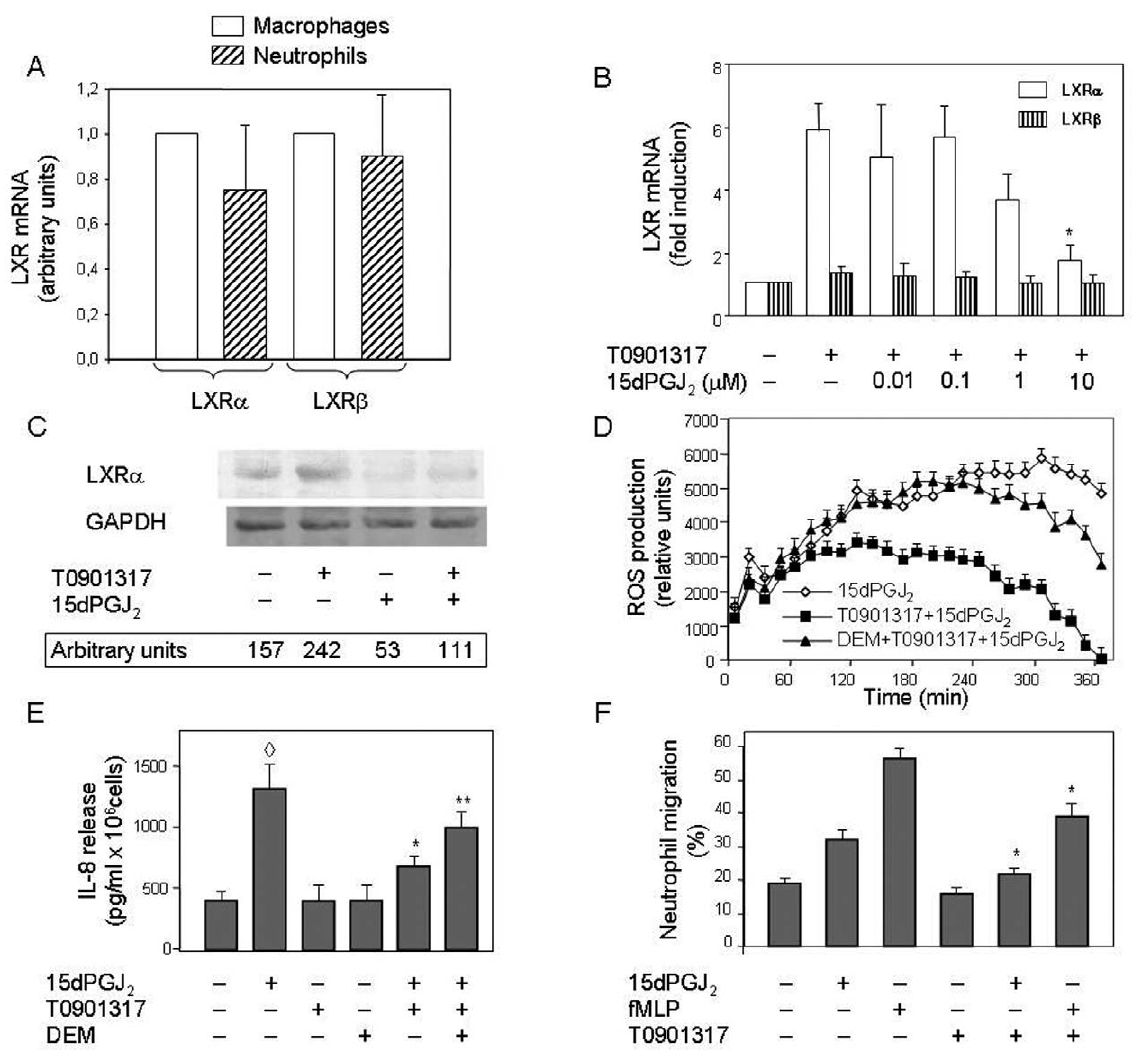
Figure 1. 15dPGJ 2 prevents ligand-induced LXR a mRNA expression in a dose-dependent manner. Neutrophils or macrophages were left untreated (A), or else neutrophils were preincubated at 37 u C for 1 h with or without 15dPGJ 2 at the indicated doses (B) or at a 10 m M concentration (C), and then they were treated or not with T0901317 for 18 h (B and C). Then LXR a and LXR b mRNA levels were measured by real time RT-PCR (A and B), or LXR a protein levels were analyzed by Western blotting (C). Statistical data from real time RT-PCR experiments were normalized to LXR a or LXR b levels found in human macrophages (A) and corrected for differences in b -actin mRNA levels (as endogenous gene) and expressed as fold induction (A and B). GAPDH bands in Western blots are shown for the sake of protein loading controls (C). In a different set of experiments, neutrophils were pretreated or not with 10 m M DEM for 30 min (D and E) and, after preincubation in the absence or presence of 1 m M T0901317 for 4 h (D and E), 10 m M 15dPGJ 2 was added and ROS levels were monitored by luminescence measurement for the next 6 h (D), or released IL-8 levels were quantitated by ELISA after an incubation period of 4 h (E). Neutrophil migration was quantitated in cells preincubated with or without 1 m M T0901317 for 4 h and then transferred to Transwell chambers and treated with 10 m M 15dPGJ 2 or 0.1 m M fMLP for 1 h. Results are expressed as the percentage of cells that migrated from the upper to the lower compartment (F). Each panel is representative of a set of three experiments yielding similar results. Values are plotted as the mean 6 SEM (n=3) (A, B, D, E and F). * P , 0.01 for T0901317-stimulated, 15dPGJ 2 (B, F) or fMLP (F)-treated versus -untreated. e P , 0.01 for 15dPGJ 2 -treated versus untreated (E). ** P , 0.01 for 15dPGJ 2 and T0901317-stimulated, DEM-treated versus - untreated (E).